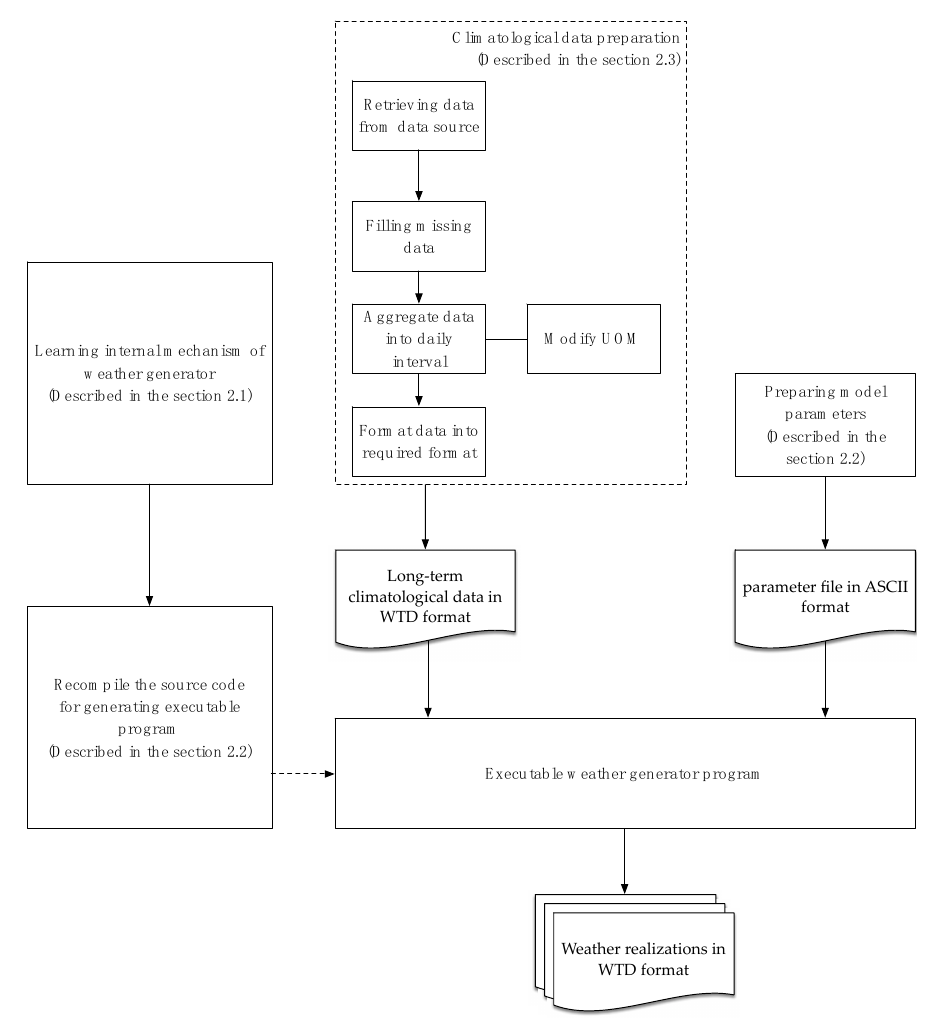
Figure 1. Overview procedures of performing weather generator in current situation.